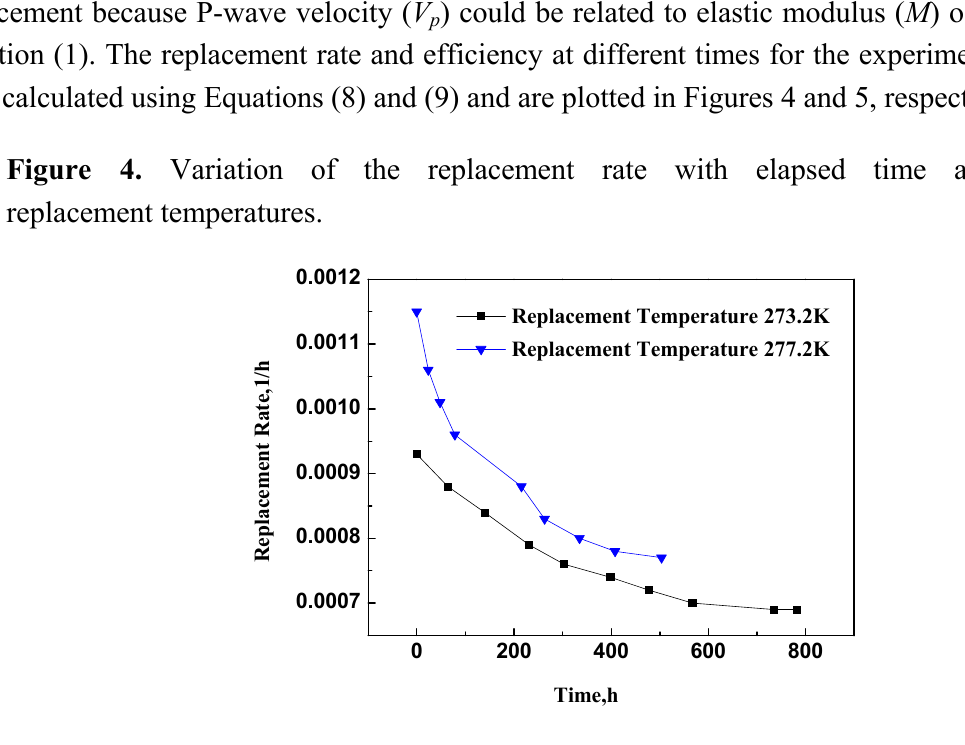
with elapsed time during the replacement process 4